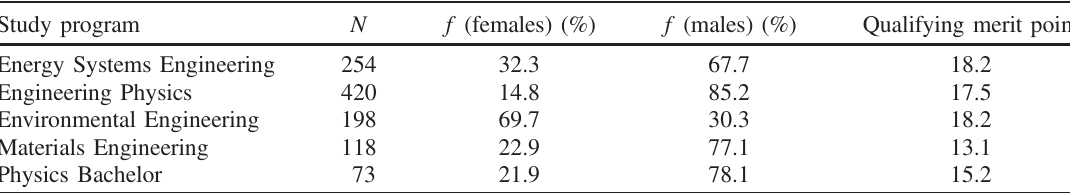
TABLE II. The largest student groups passing the electromagnetism course, Fall 2007 to Spring 2013. The qualifying merit point is the minimum average grade from secondary education (high school), which was needed to be accepted into the program (average for 2008 – 2011). The merit point is calculated as an average of the students ’ best 17 grades from Swedish secondary education: Pass, Pass with distinction and Pass with special distinction, with numerical equivalents of 10, 15 and